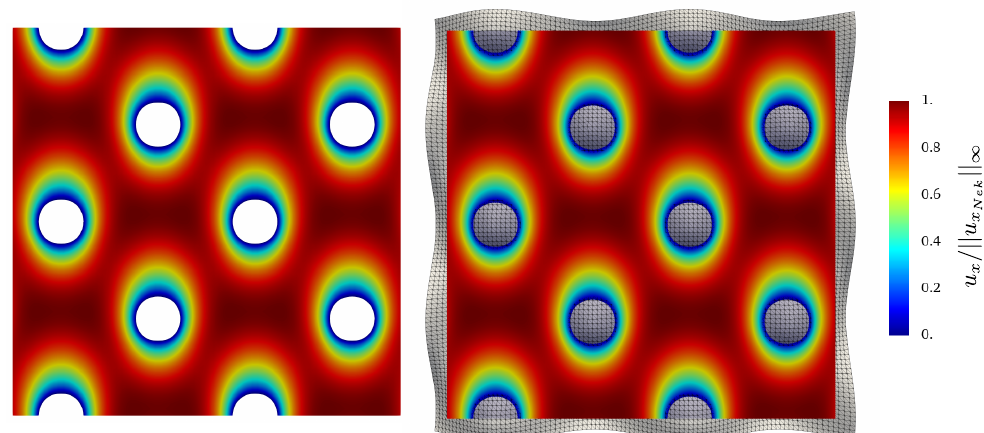
|| ∞ at the steady state on a plane located at y = 0.15 orthogonal to Figure 13. Contours of u x / || u x Nek the y axis. Left: Nek5000, right: Direction Splitting, h s / ∆ x = 96.